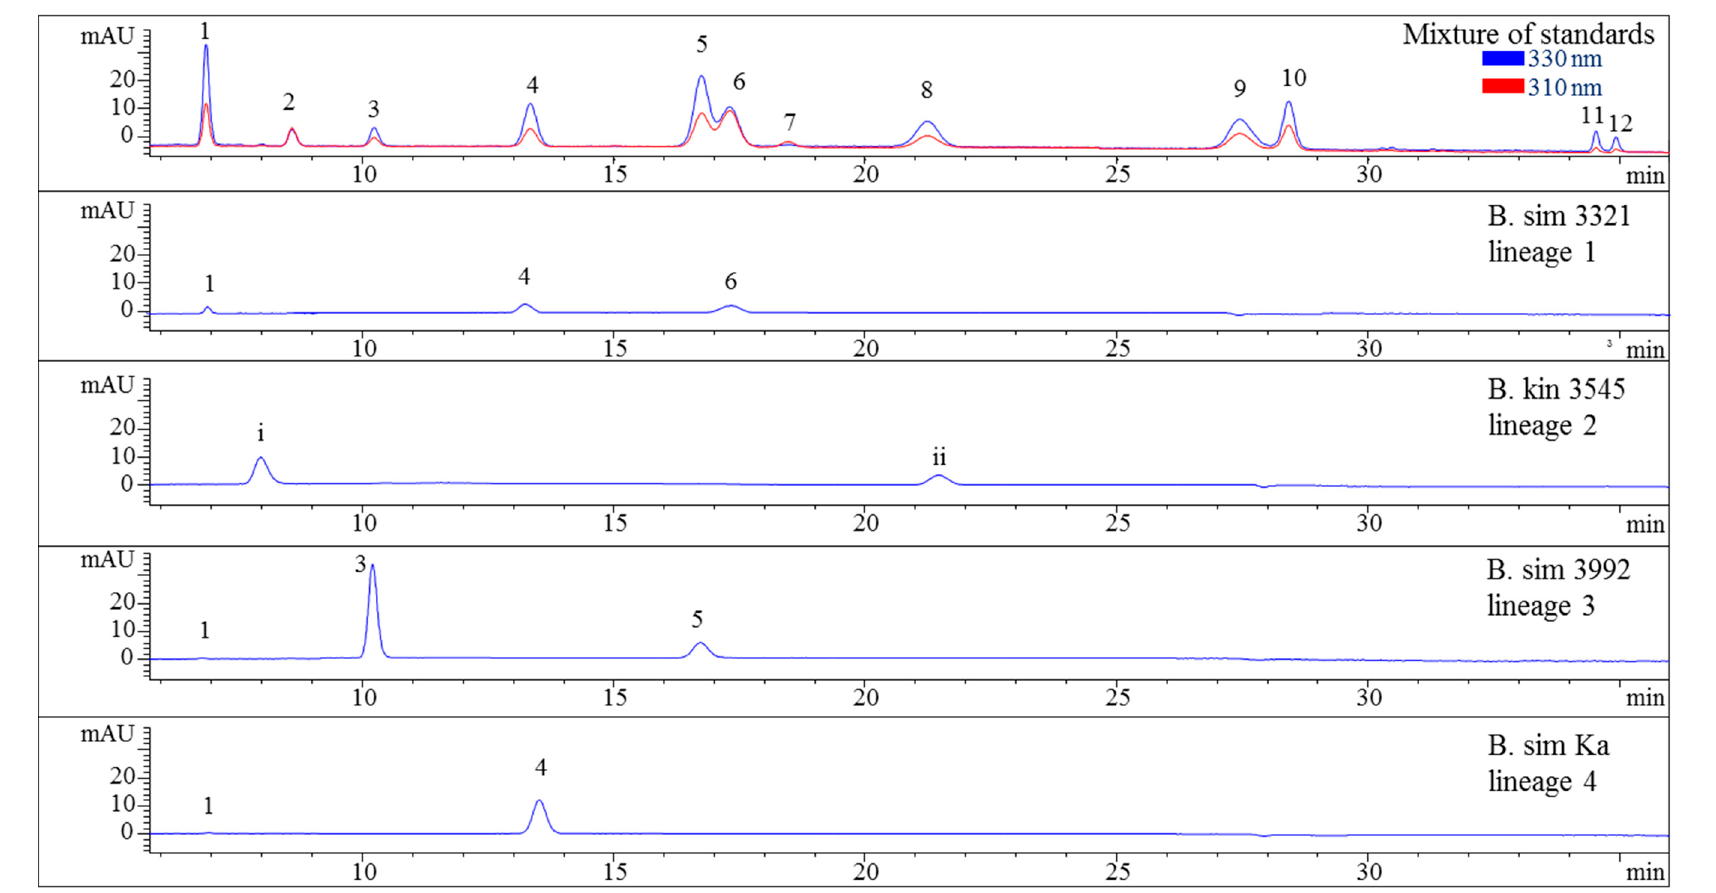
Figure 2. HPLC chromatograms of selected representatives of the four lineages of the B. simpliciuscula / B. kingii complex. Assignment of the compounds is according to Figure 1 and (i) unidentified MAA at 9.9 min with λ max 318 nm and m / z 294, (ii) unidentified MAA at 21.5 min with λ max 308 nm and m / z 316. The assignment of 5 as Aplysiapalythine A is tentative. Assignment of the species: B sim, B . simpliciuscula ; B kin, B . kingii .